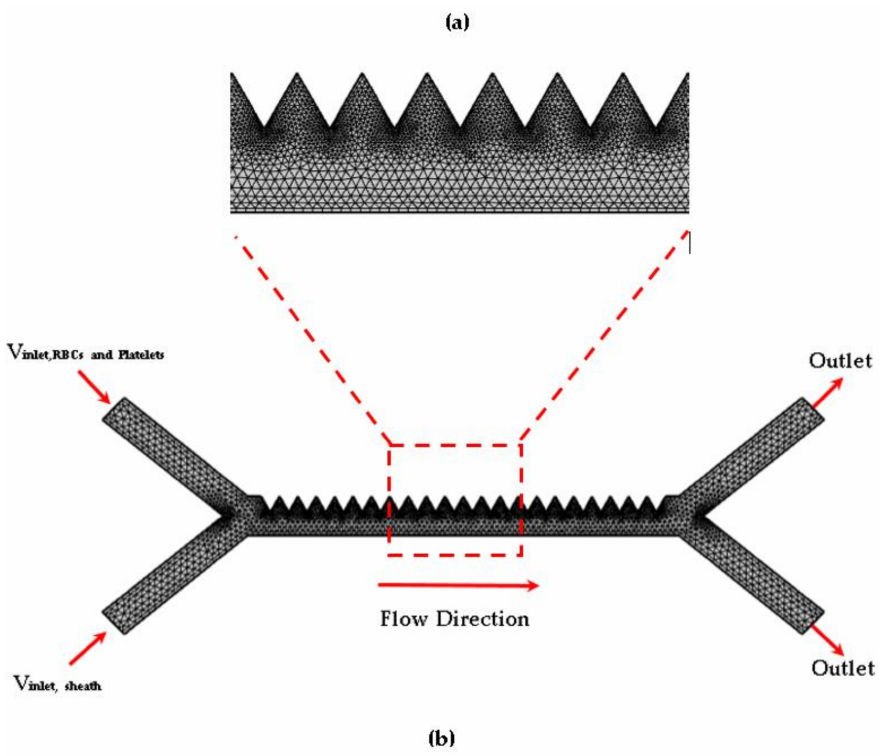
Figure 1. Selected computational mesh for the proposed design analysis: ( a ) zoomed in view and ( b ) full